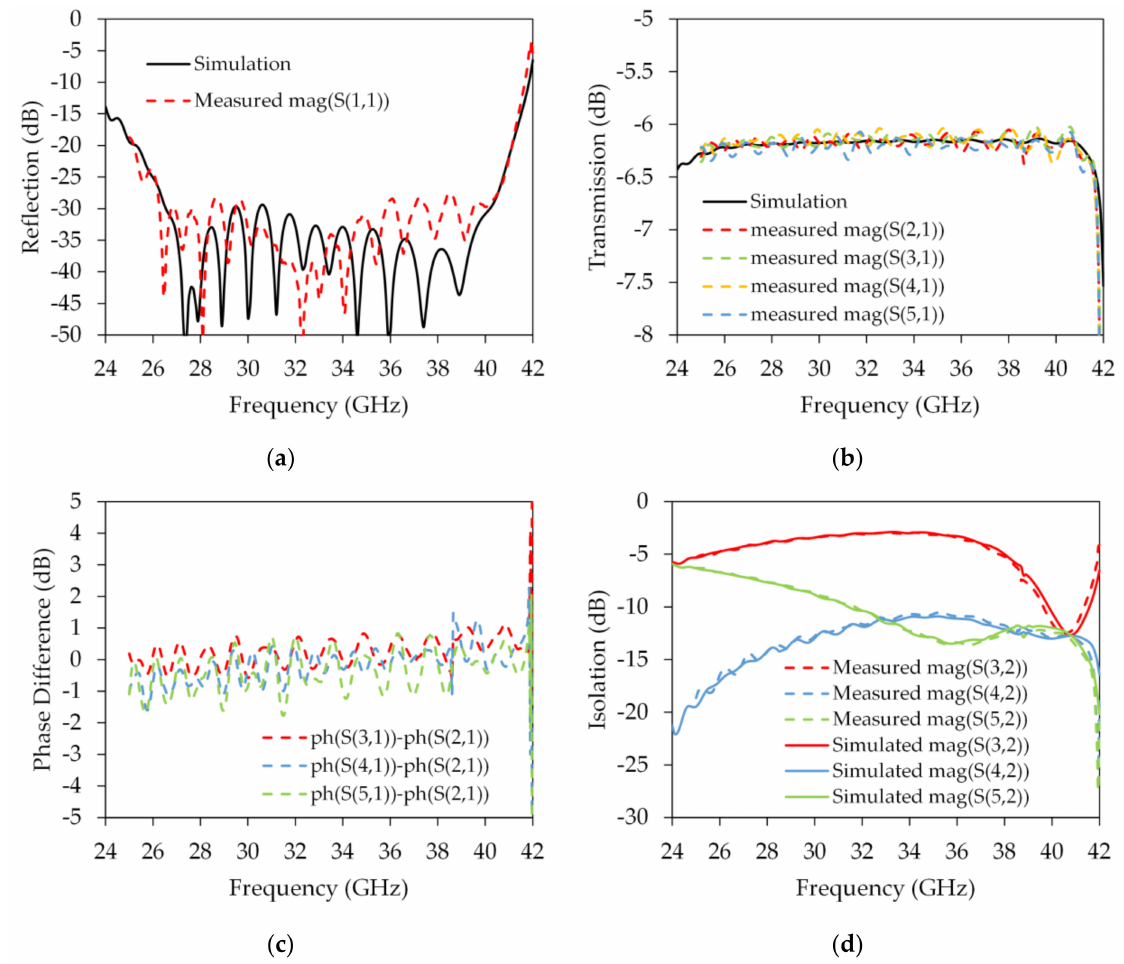
Figure 12. Measured results of the proposed power divider/combiner: ( a ) reflection at common port (simulation with HFSS in solid red line and measurement in dashed blue line); ( b ) transmission from input port to all output ports (simulation with HFSS in solid black line and measurements in dashed colored lines); ( c ) measured phase differences between transmission measurements and a transmission measurement taken as a reference; ( d ) isolations between output ports (simulations with HFSS in solid lines and measurements in dashed lines). Opposite ports in red lines and orthogonal ports in blue and green